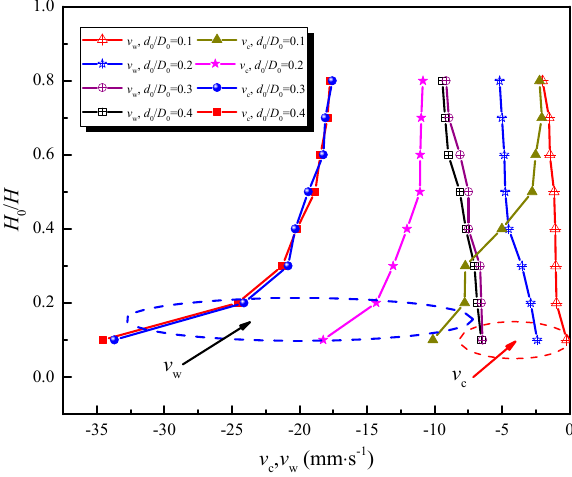
Figure 11. The evolution of sinter layer velocity along the vertical direction with different normalized outlet scales.